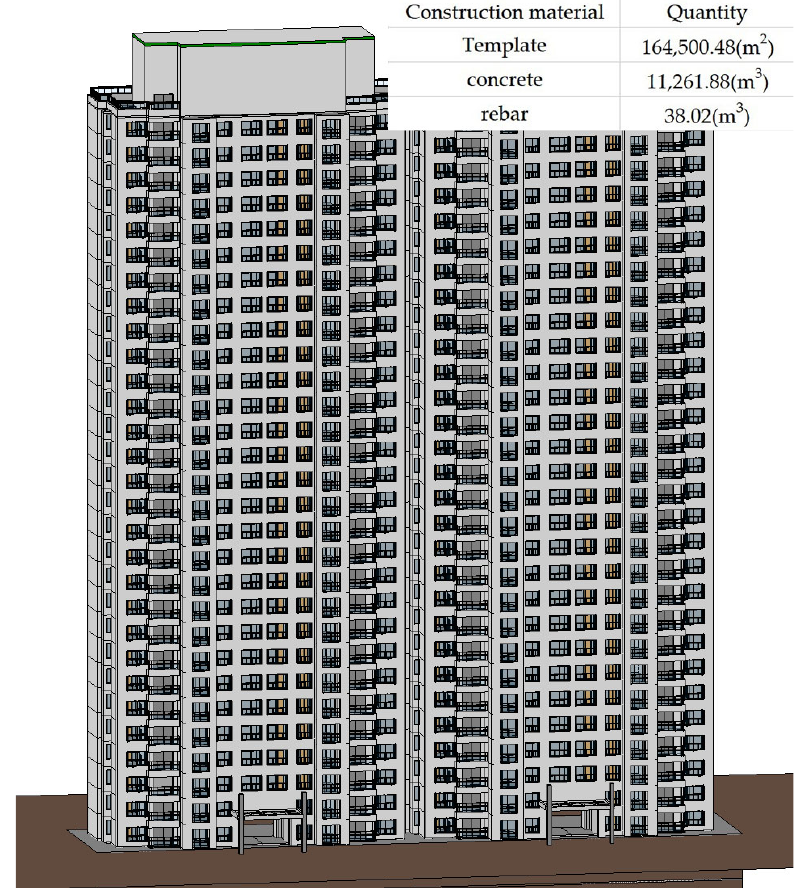
Figure 3. BIM model of the project and corresponding quantity of building materials.